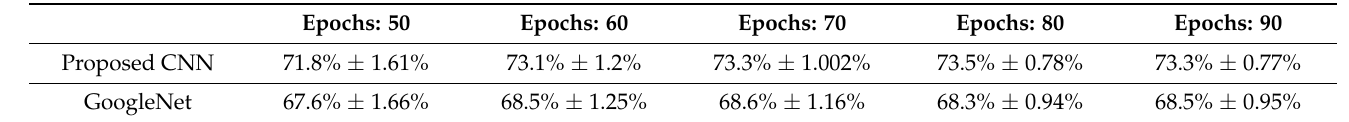
Table 8. Learning Test Accuracy by